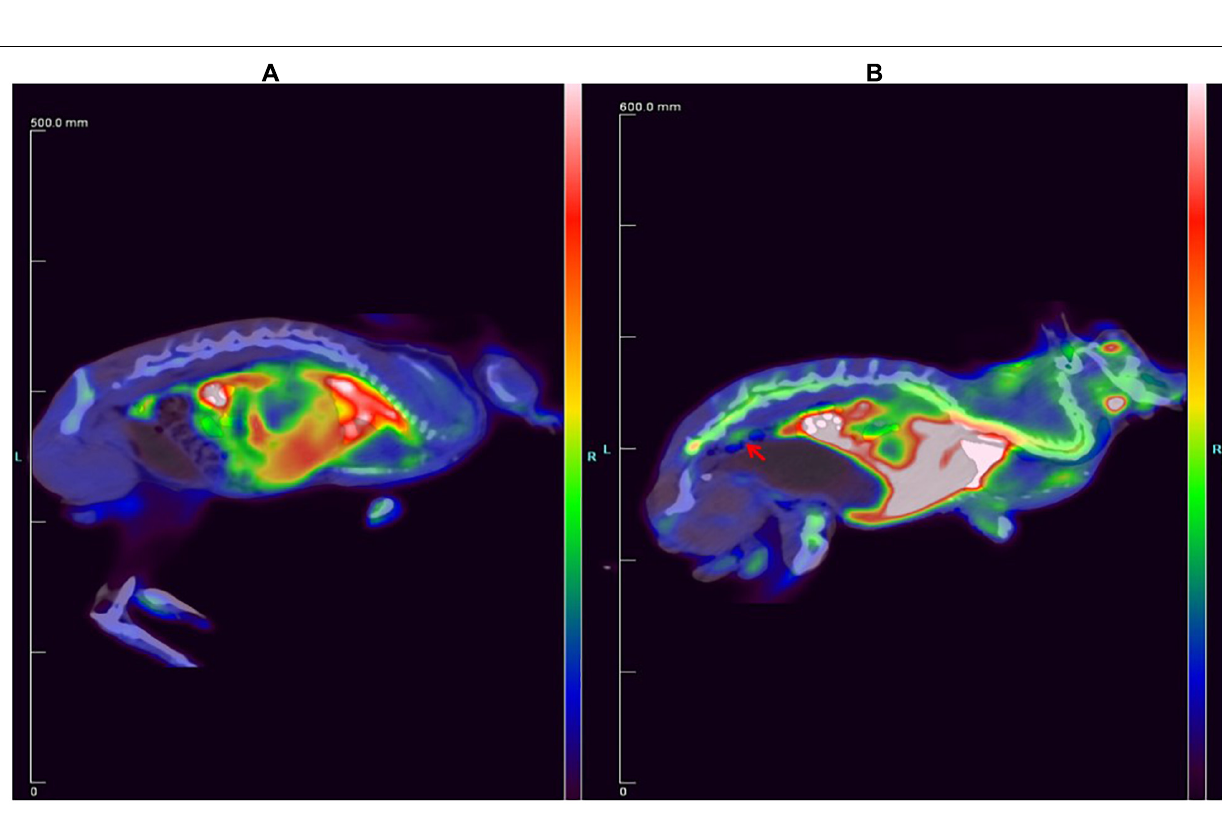
Frontiers in Bioengineering and Biotechnology |